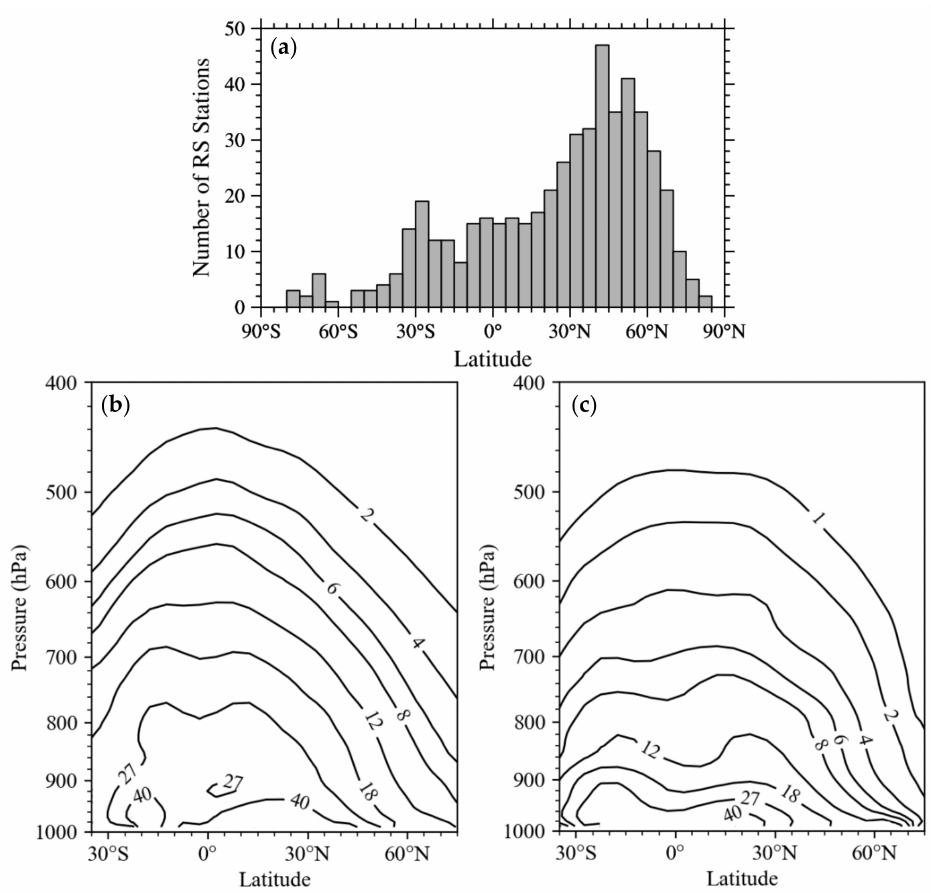
Figure 5. ( a ) The RS station numbers at 5 ◦ -latitude interval, as well as ( b ) mean ( µ ) and ( c ) standard deviation ( σ ) of RO refractivity error variance (unit: N-unit 2 ), in which contours are plotted at the interval of log µ = 0.4 and log σ = 0.4 for ( b ) and ( c ),